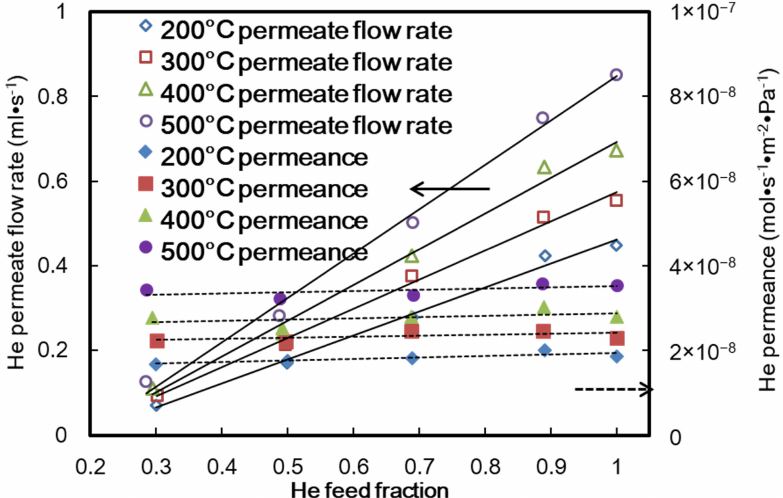
Figure 7. He permeation performance of cobalt oxide silica